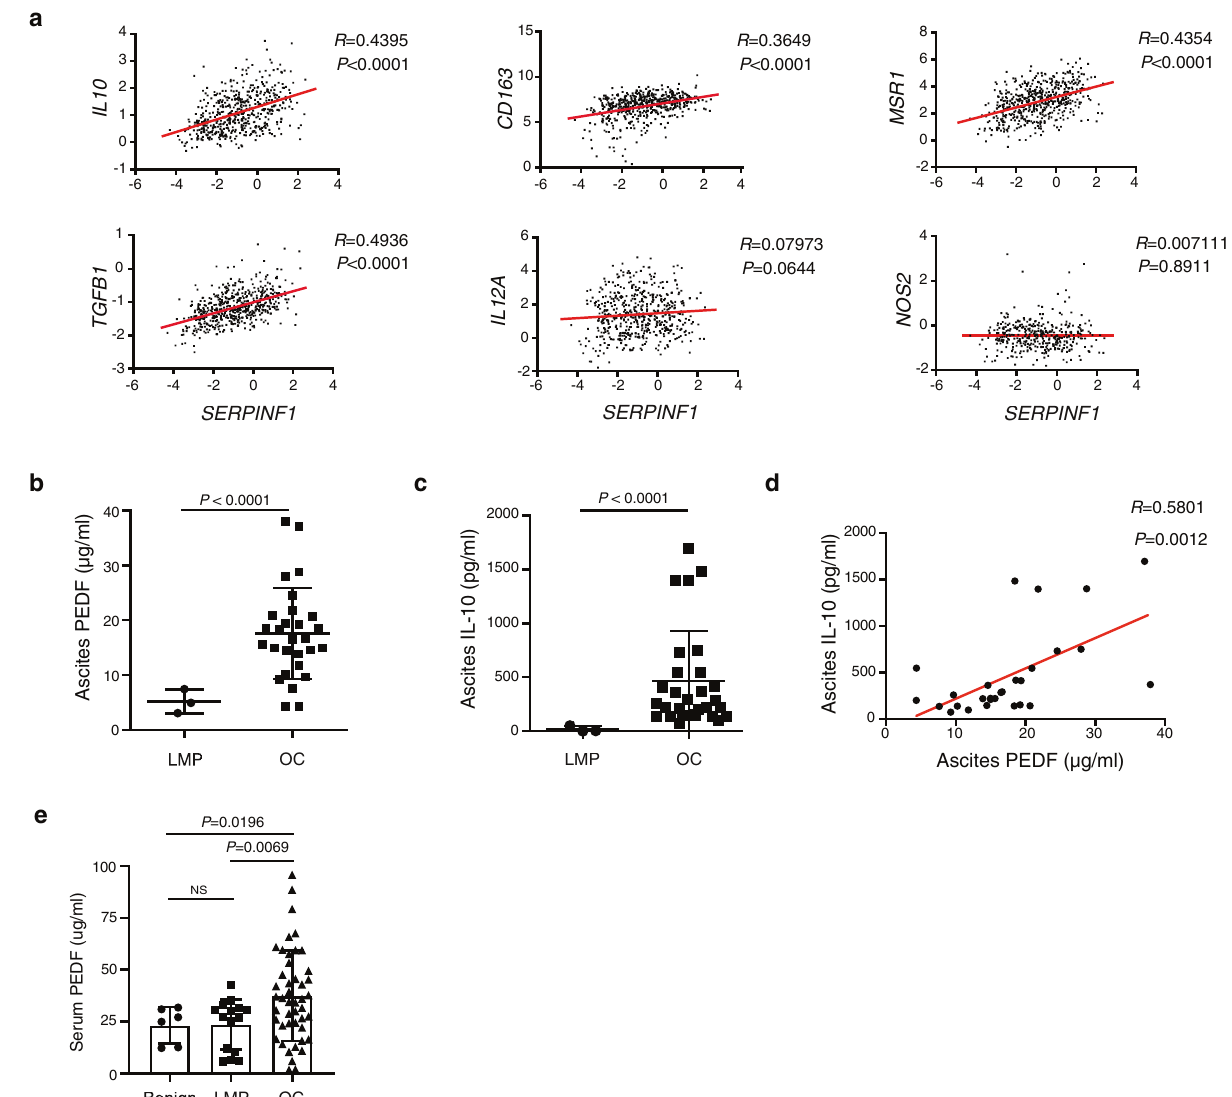
Fig. 6 PEDF levels in ascites fl uid and serum samples are increased in OC patients. a Pearson ’ s correlation analysis for expression of SERPINF1 versus that of IL10 , CD163 , MSR1 , TGFB1 , IL12A , or NOS2 in human OC samples of TCGA ( n = 531). b PEDF concentration as measured with an ELISA in ascites specimens of patients with LMP ovarian tumors ( n = 3) or OC ( n = 28). c Concentration of IL-10 in ascites samples of patients with LMP tumors ( n = 3) or OC ( n = 28) as measured with an ELISA. d Pearson ’ s correlation analysis for IL-10 and PEDF concentrations in ascites specimens of patients with OC ( n = 28). e Serum PEDF concentration of patients with benign ovarian tumors ( n = 6), LMP tumors ( n = 15), or OC ( n = 46) as measured with an ELISA. Data are means ± SD and were analyzed by Welch ’ s ANOVA followed by Dunnett ’ s post hoc test. Data for b , c are means ± SD and were analyzed by unpaired t test with Welch ’ s